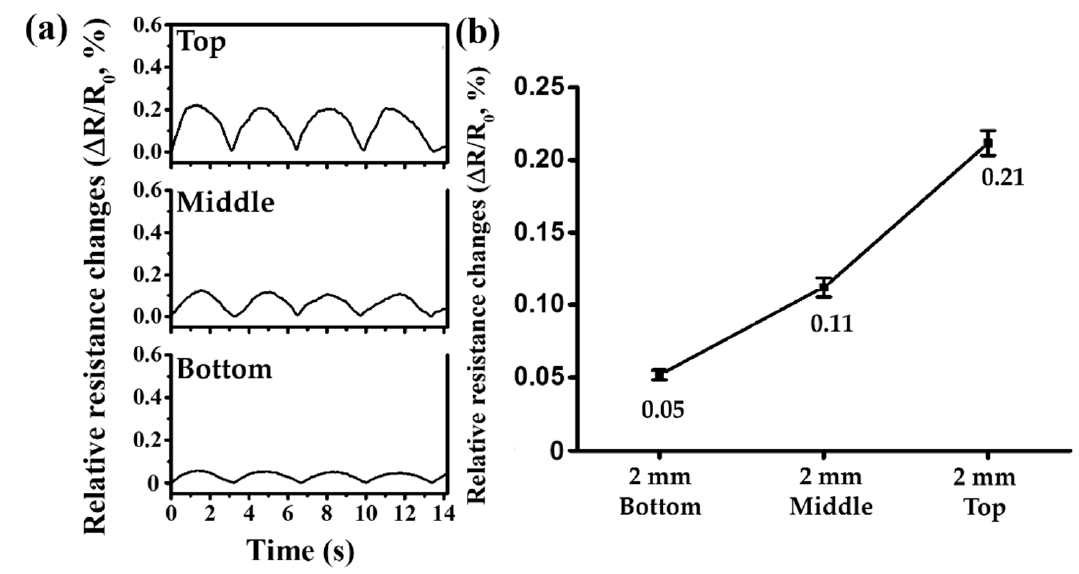
Figure 7. Experimental results of the relative electrical resistance changes in the vessels of 2 mm diameter: ( a ) changes in relative electrical resistances at the Top, Middle, and Bottom positions; ( b ) graph of mean relative changes in electrical resistances at the Top, Middle, and Bottom positions. The 2 mm vessels have average relative electrical resistance changes of 0.05%, 0.11%, and 0.21% at the Bottom, Middle, and Top positions, with standard deviations of 0.0034%, 0.0069%, and 0.0086%,